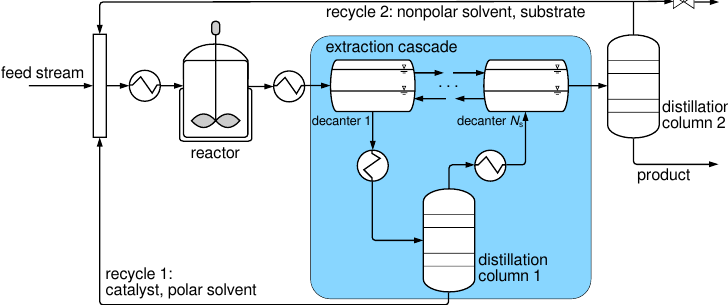
Figure 3. Modified hydroformylation process adapted from [10]. The highlighted area marks the extraction cascade with extraction solvent recycle considered in the present